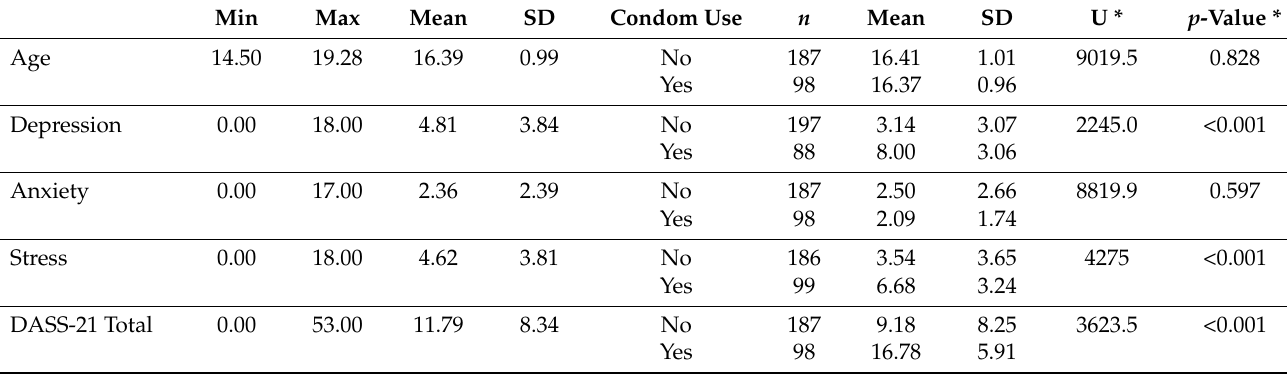
Table 2. Mean values of quantitative variables for condom